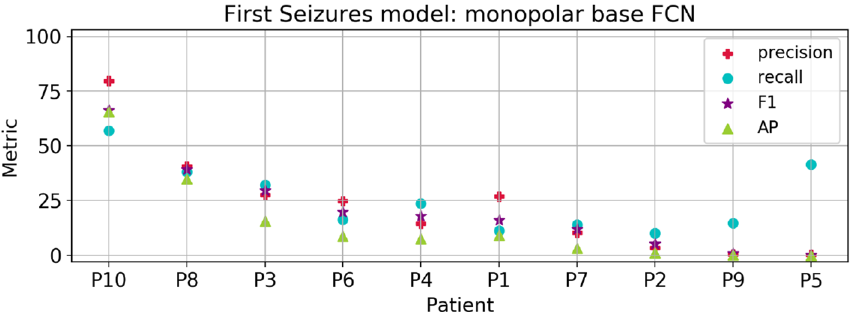
Figure 6. Average metrics for the best experiment in EPILEPSIAE patients using scalp electrodes only. Patients in the x-axis are sorted by decreasing F-measure (purple star marker).